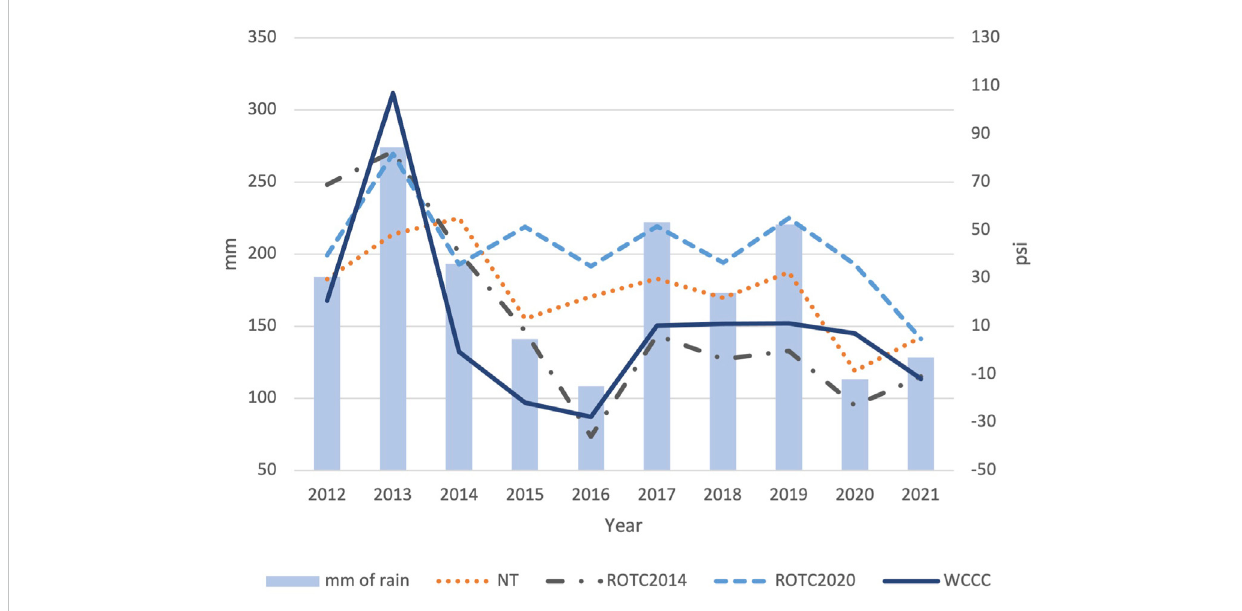
FIGURE 2 Antecedent moisture condition during spring soil sample collection and surfacehardness measurements by year. Antecedent moisture condition is total precipitation in April and May months for each year recorded at Burlington International Airport weather station in VT, United